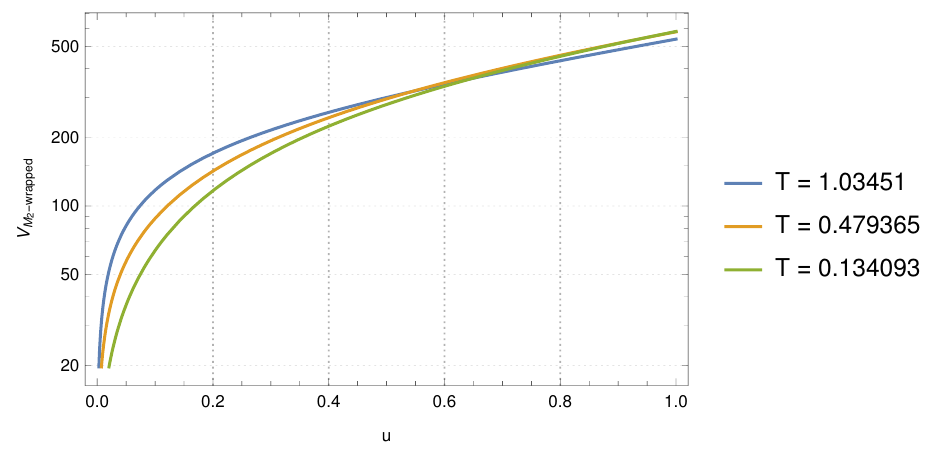
= 1 / 100 (blue), P = 152 / 25 (orange) 2 2